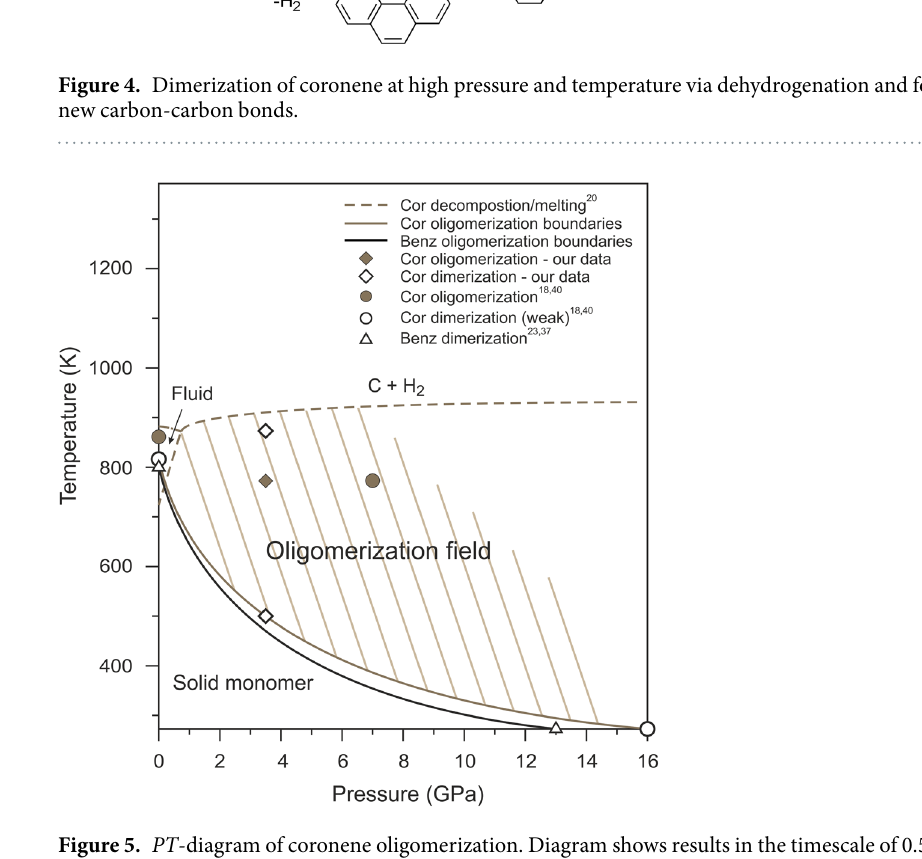
Figure 5. PT -diagram of coronene oligomerization. Diagram shows results in the timescale of 0.5–6 hours. Dimerization curves of coronene and benzene 23, 37 are almost equals in the pressure range of 0–16 GPa. The shaded area corresponds to the coronene oligomerization field. Benz – benzene, Cor –